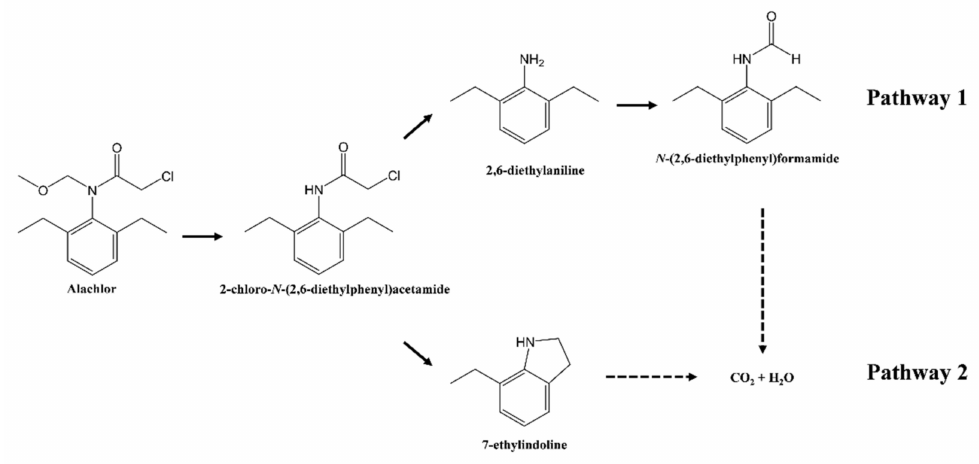
Figure 6. Proposed biodegradation pathway of alachlor by Acinetobacter sp.